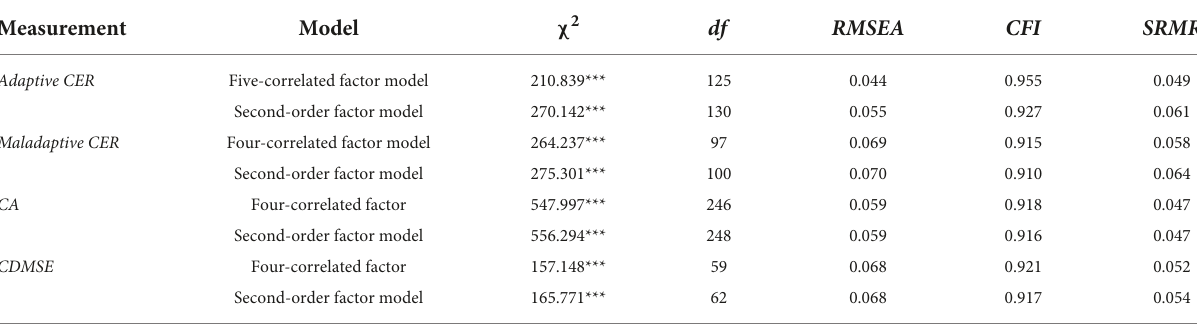
TABLE 2 Confirmatory factor analysis